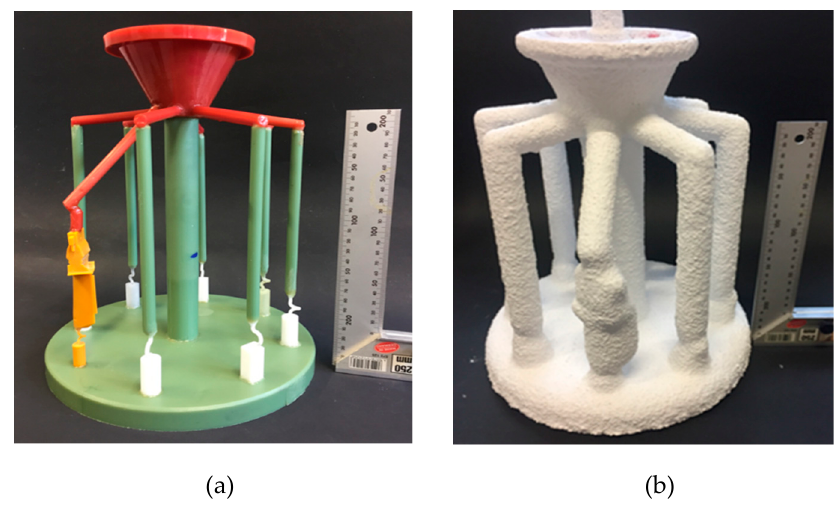
Figure 2. Images of ( a ) the wax model and ( b ) the shell mold.